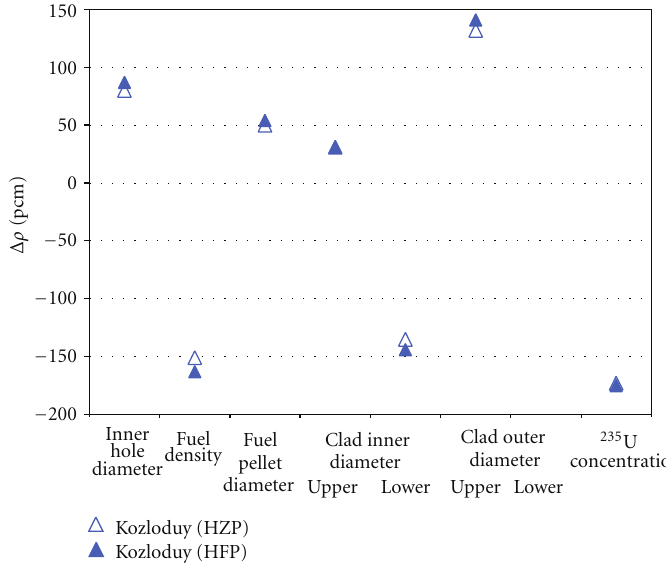
Figure 9: Manufacturing sensitivities for Kozloduy-6 test case.